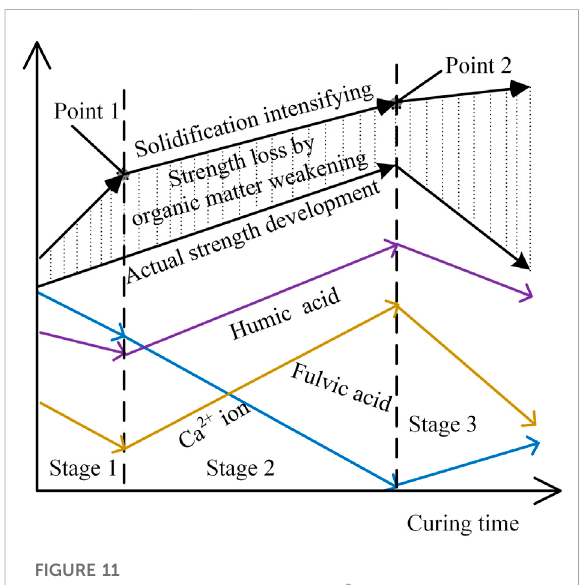
FIGURE 11 Development of strength, acids, and Ca 2+ ion